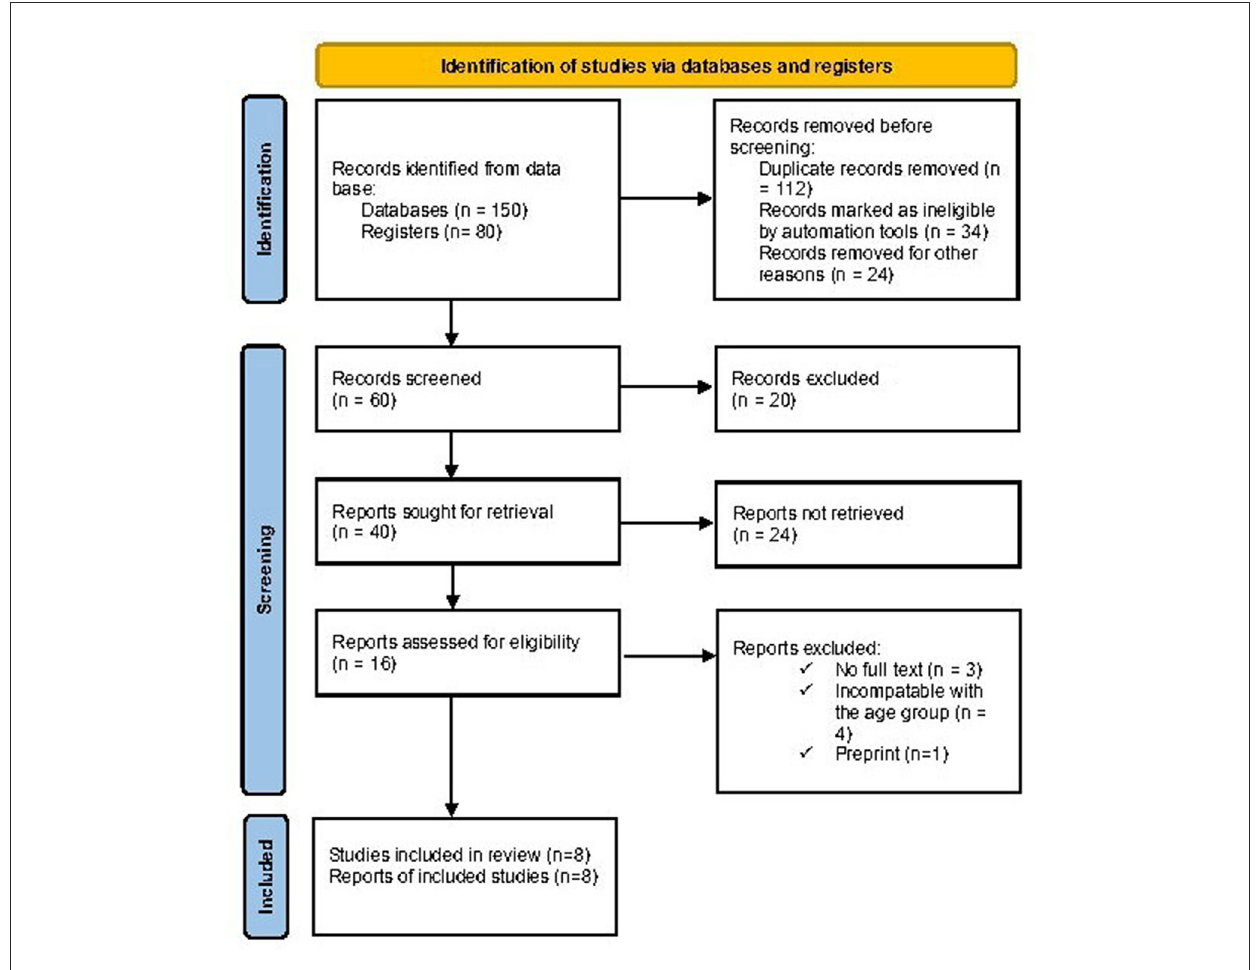
FIGURE1 PRISMA flow